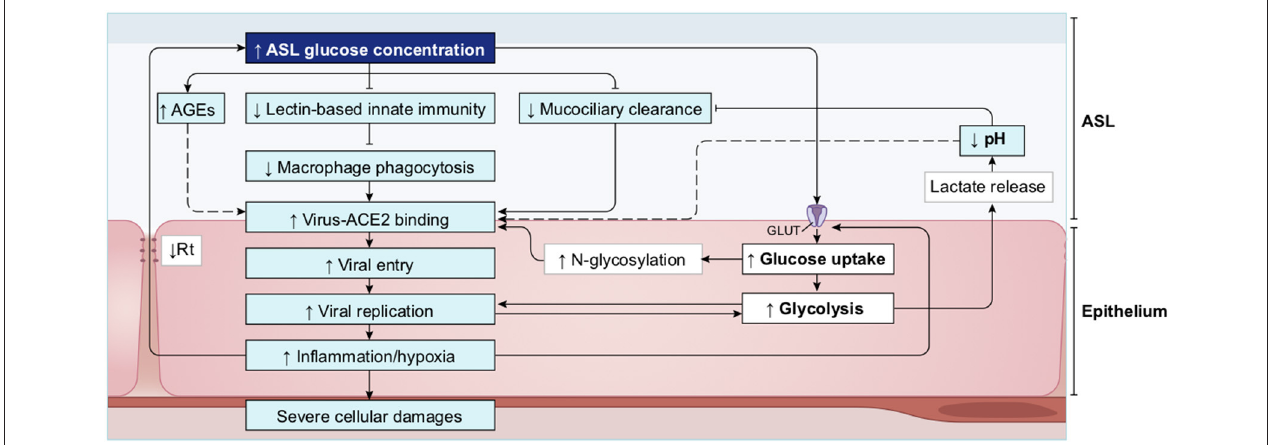
FIGURE 20 | Graphical representation of the effects of high glucose in ASL on SARS-CoV-2 primary infection and viral replication. Elevation of glucose in the ASL has multiple consequences on the primary innate defense functions of the ASL (decreased MCC, lectin and macrophages activities, increased production of AGEs, acidification of the ASL; detailed in Figure 15 ) with the consequence of an increase capability of the virus to reach and bind its receptor. Acidic pH could also favor the viral entry process. Elevation of glucose in the ASL also increases the glucose uptake inside the cell, favoring the cellular replication capacity of the virus, that hijacks the host glycolysis and N-glycosylation pathways. High viral replication provokes inflammation and hypoxia that tend to affect the paracellular resistance (Rt) of the cell aggravating the efflux of glucose in the ASL. Hypoxia also leads to increase the expression of GLUT transorters and glycolytic genes amplifying the glycolytic rate, and in consequence, the viral replication rate, the production of lactate, the decrease of the pH in the ASL, in a vicious circle of infection escalation. AGEs, Advanced glycation end products; Rt, epithelial resistance; GLUT, Glucose